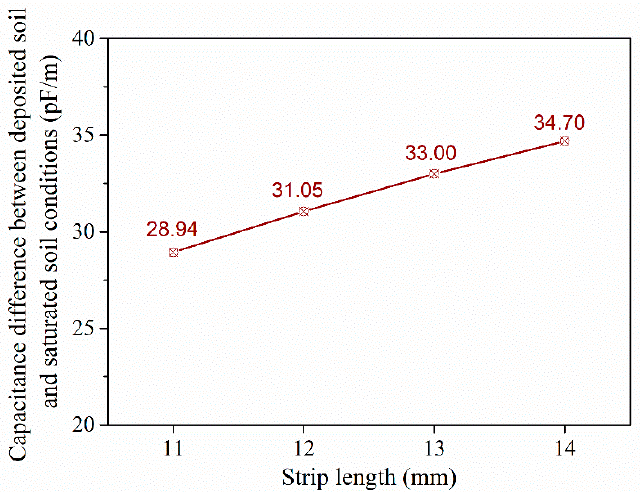
Figure 10. Capacitance difference obtained between deposited and saturated soil conditions for various electrode lengths of 11, 12, 13 and 14 mm. Increased electrodes lengths resulted in a corresponding increase in the capacitance difference computed between the two simulated conditions.